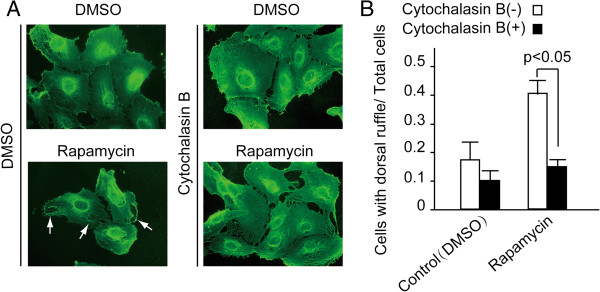
The membrane remodeling is essential for platelet-endothelial adhesion. HUVECs were treated with the indicated reagents. Cells were fixed and detected by immunofluorescence with an anti-β-actin antibody. (A) The dorsal ruffle was indicated by arrows. (B) The ratio of cells with dorsal ruffle to total cells was evaluated. The data showed that Cytochalasin B attenuated platelets-endothelial adhesion which was induced by rapamycin. Means ± SD are given and were obtained from 3 independent experiments.